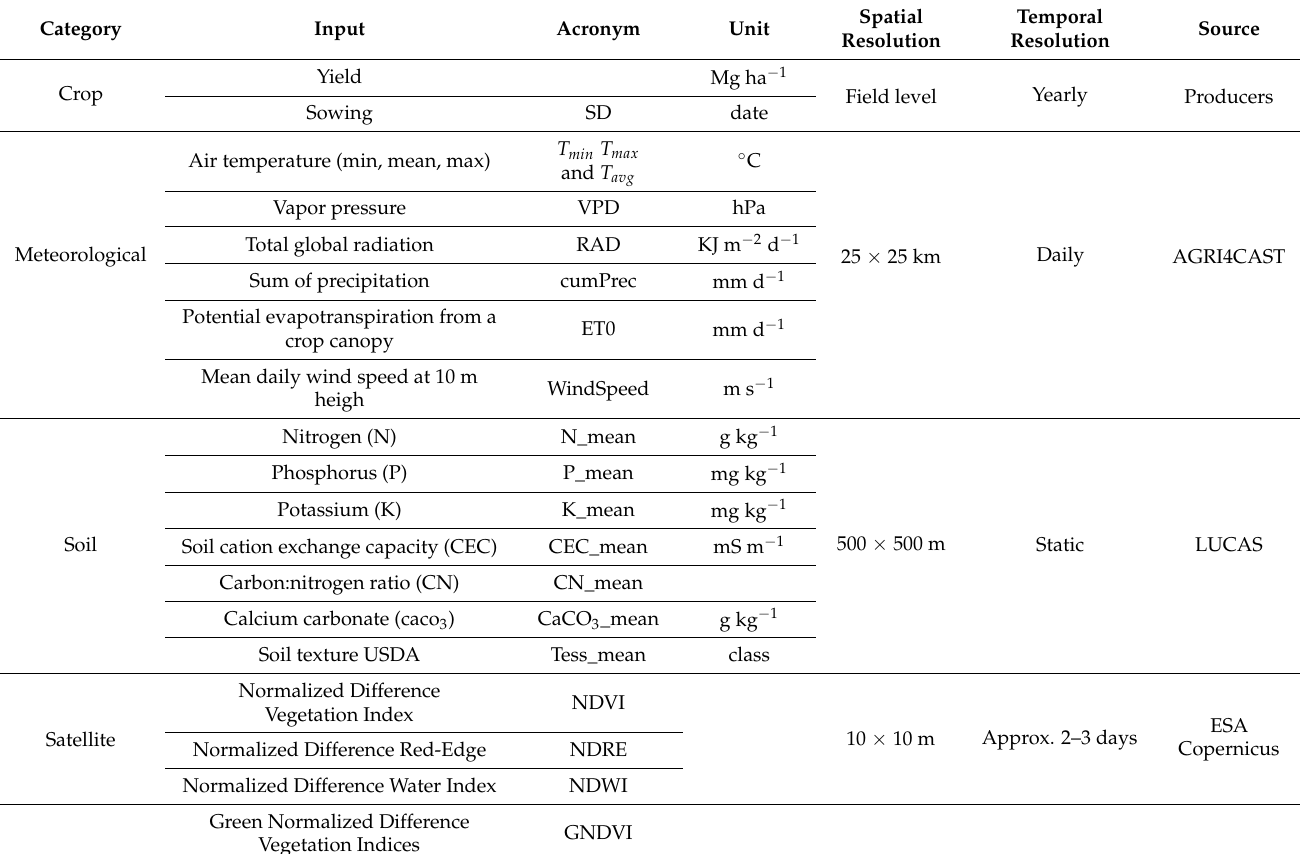
Table 1. Summary of the datasets